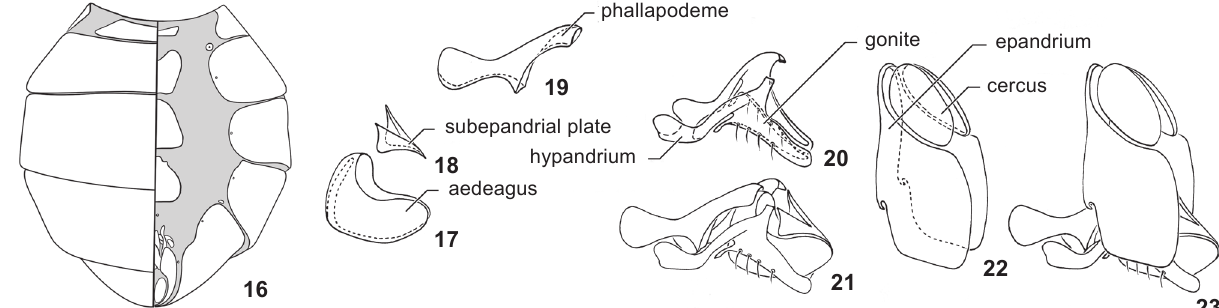
Figures 16-23. Parydra humilis : (16) abdomen of male, dorsal and ventral views; (17) aedeagus, latero-oblique view; (18) subepandrial plate, latero-oblique view; (19) phallapodeme, latero-oblique view; (20) gonite and hypandrium, latero-oblique view; (21) aedeagus, gonite, hypandrium, phallapodeme, latero-oblique view; (22) epandrium and cercus, latero-oblique view; (23) male terminalia, latero- oblique view. Scale bars: 16 = 0.5 mm, 17-23 = 0.25